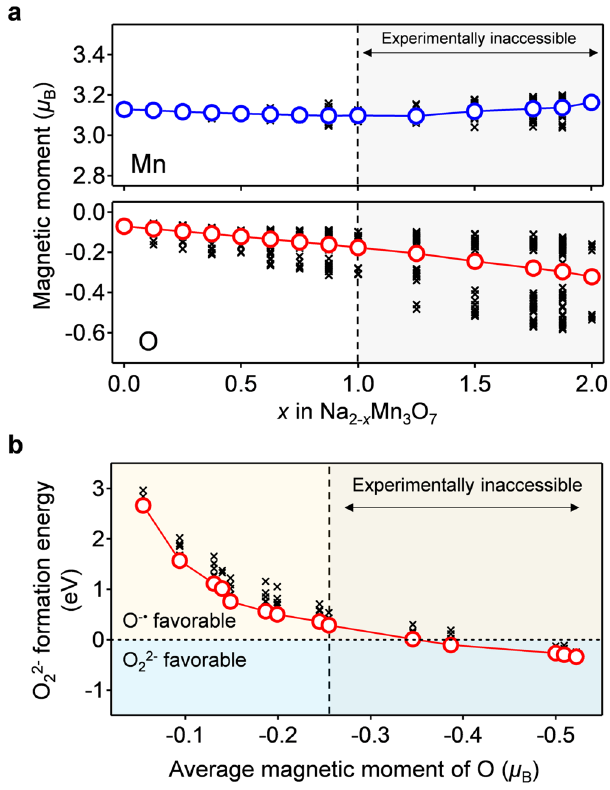
Fig. 4 Theoretical derivation of stable existence of O − (cid:129) in Na 2- x Mn 3 O 7 . a Calculated magnetic moments of Mn and O as a function of x in Na 2- x Mn 3 O 7 , and b calculated formation energy of peroxide-like O 2 2 − as a function of the average magnetic moment (i.e., degree of oxidation) of O in Na 2- x Mn 3 O 7 . For the plots of the magnetic moments, black crosses are a magnetic moment of each atom, while blue and red circles are average magnetic moments. For the plot of the formation energy, black crosses represent the formation energy of various O-O pairs, while red circles represent the lowest value at each desodiated state. Gray shaded area is experimentally inaccessible due to too high desodiation potential (see Supplementary Fig.